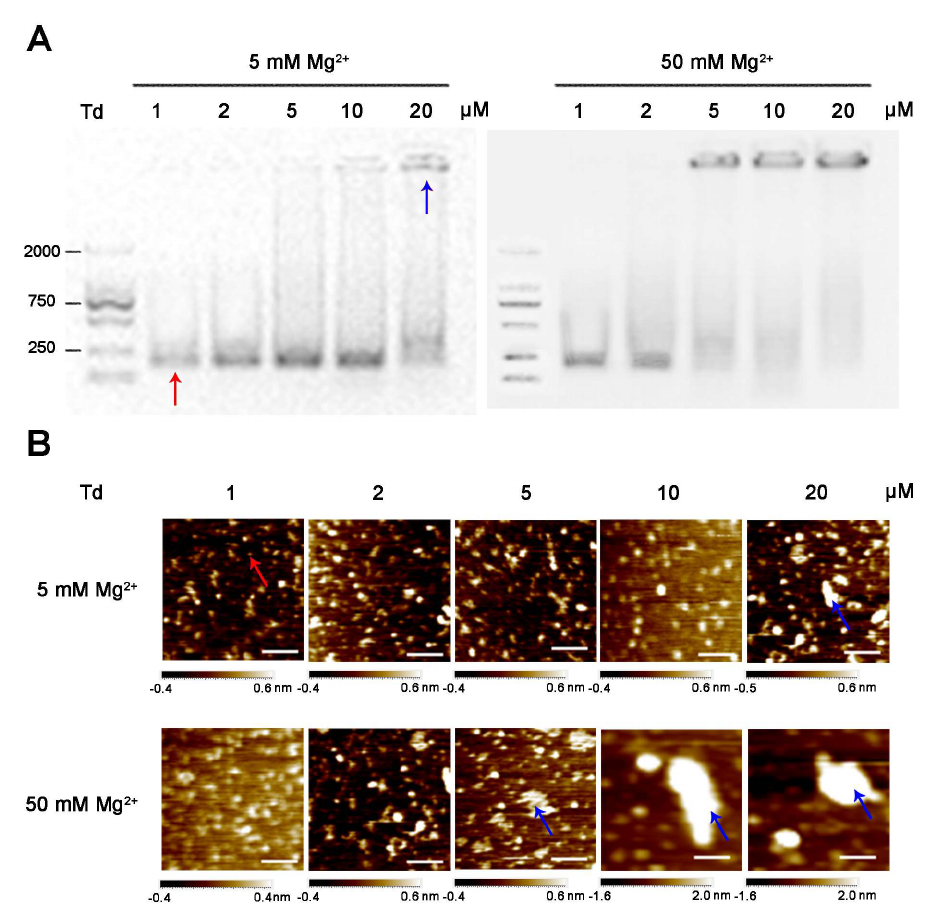
Figure 1. Characteristics of tetrahedrons (Tds) (1, 2, 5, 10 and 20 μM) prepared in 5 and 50 mM Mg 2+ . ( A ) Agarose gel of DNA products. ( B ) AFM images of DNA products. Scale bars: 100 nm. Red and blue arrows represent successfully assembled Td and aggregated DNA, respectively.